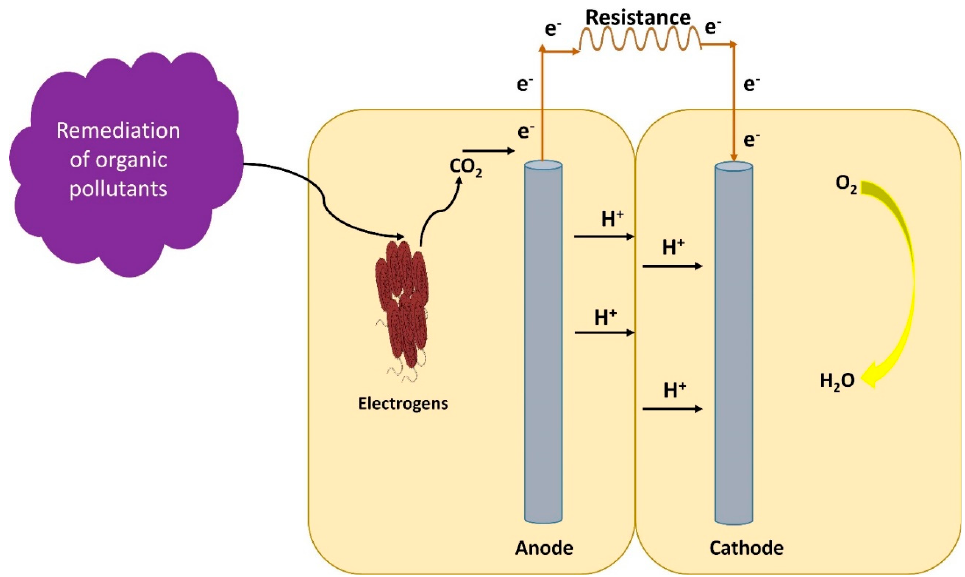
Figure 2. Overview of organic pollutants removal by benthic microbial fuel cell.